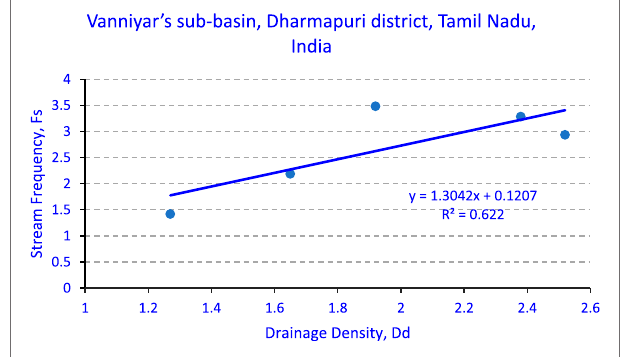
FIGURE 12 | Graphical representation of the shape factor.